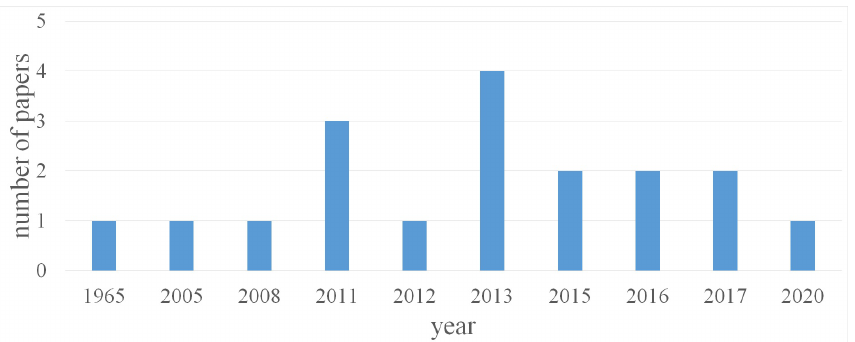
Figure 1. Number of papers per year on physical experiments for partial blockage (PB) detection involving transient tests. Table 2. Selected papers with the main characteristics of the executed physical experimental